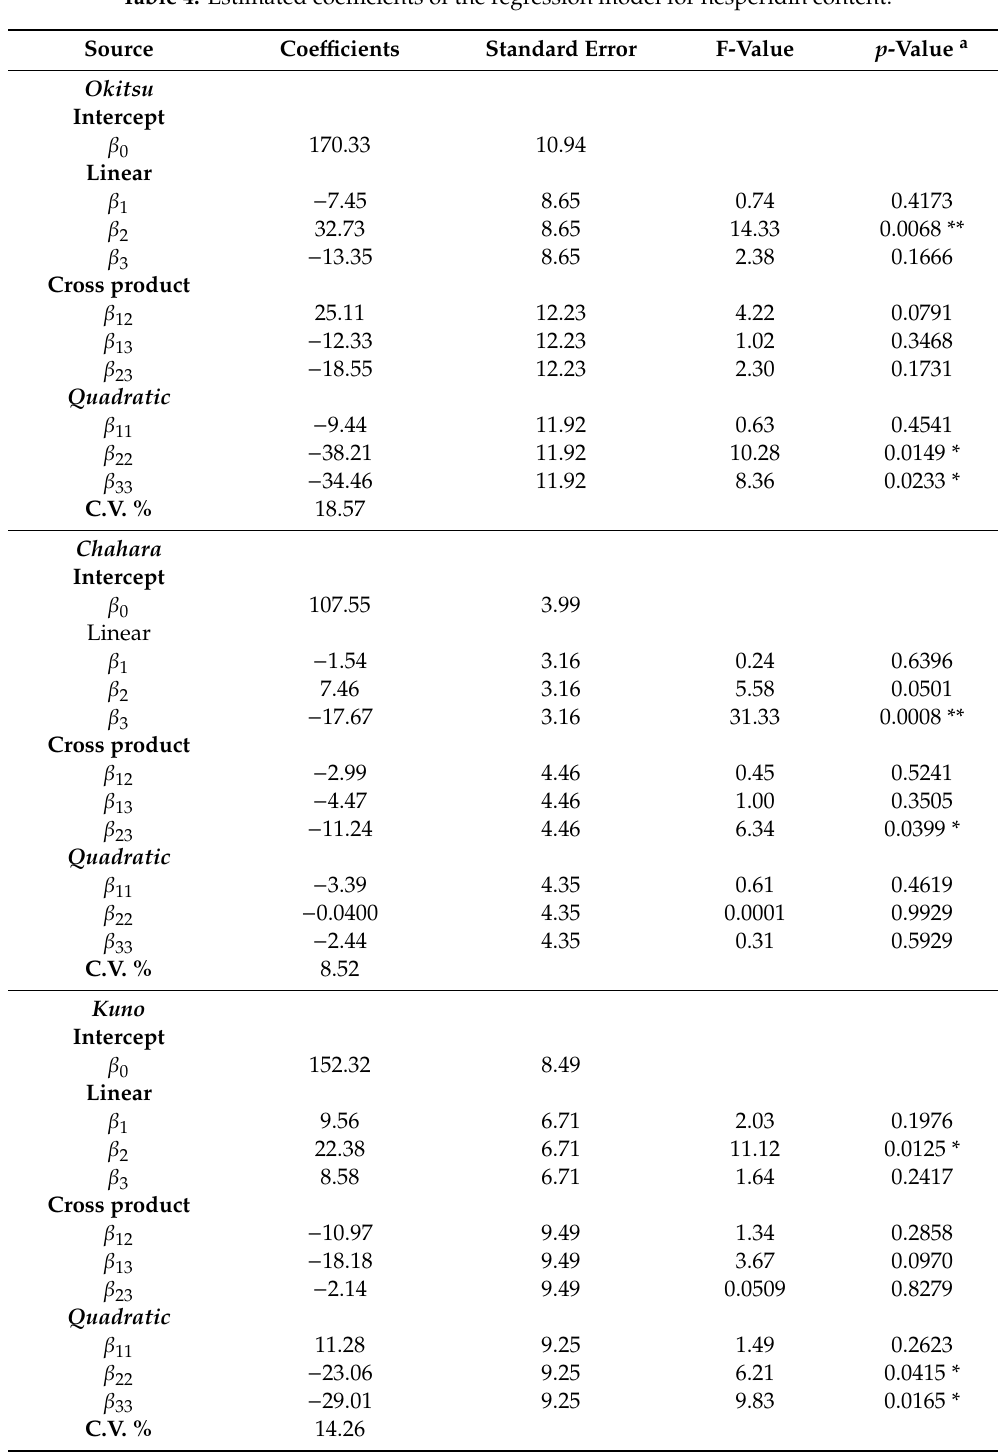
Table 4. Estimated coe ffi cients of the regression model for hesperidin